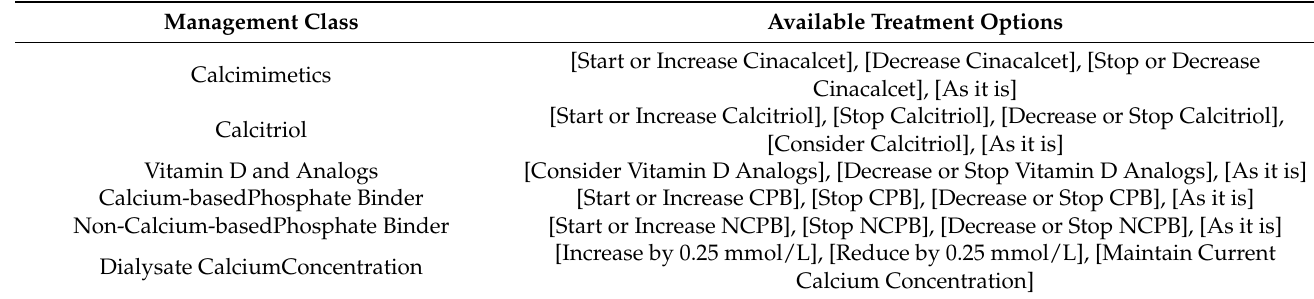
Table 6. Generic Recommendation